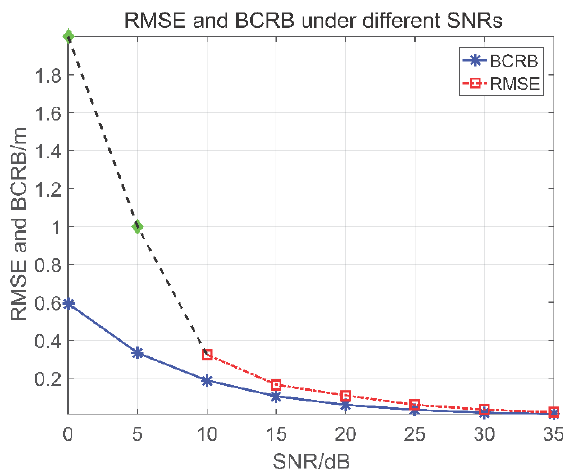
Figure 8. Comparison between RMSE and BCRB under different SNRs.